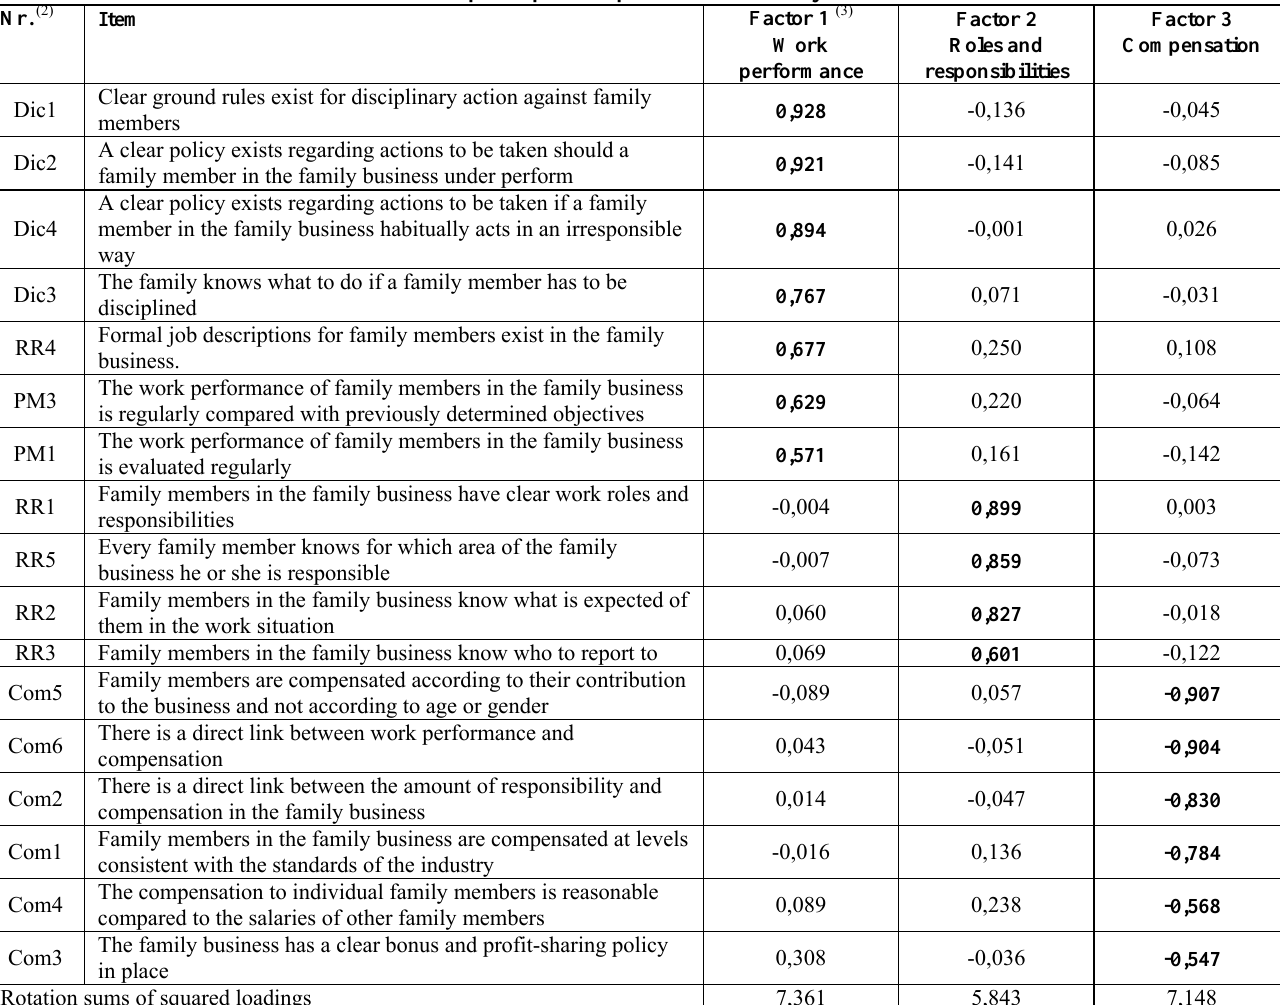
Table 2: Pattern matrix of Oblimin rotated-principal component factor analysis (1) Nr.